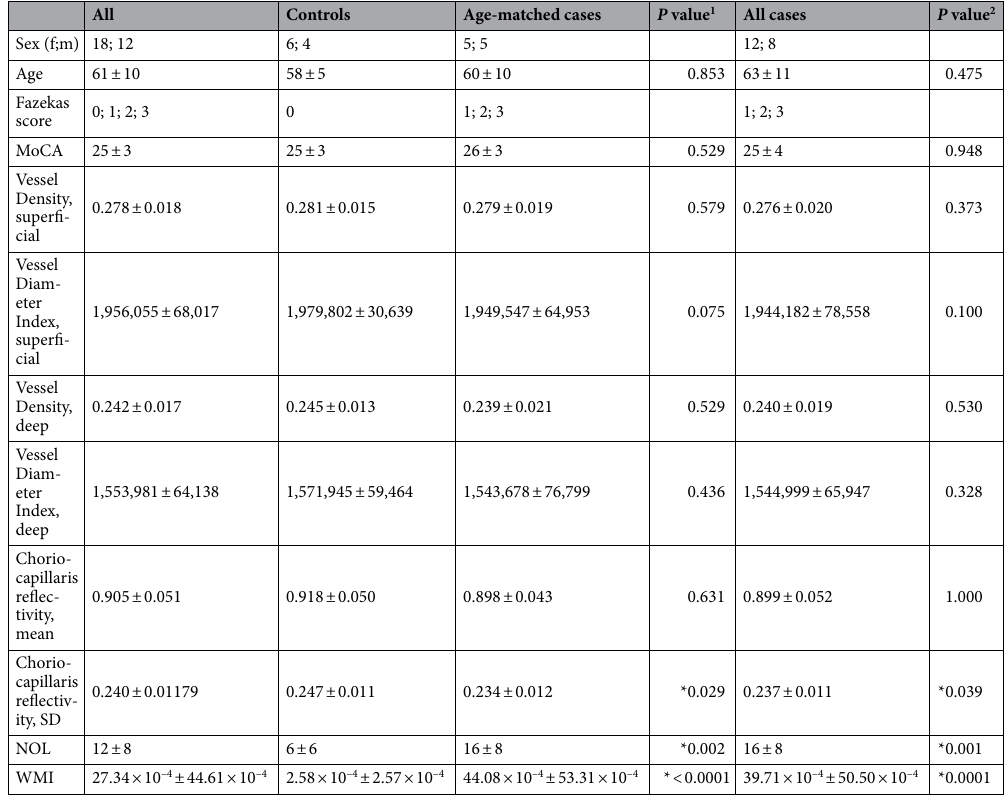
were healthy controls (Fazekas score 0) and 20 participants had CSVD (Fazekas score 1, n = 11; Fazekas score ≥ 2, n = 9). The average MoCA score was 25 ± 3 points, with no significant difference between cases and controls ( p = 0.948). In the total sample, choriocapillaris reflectivity standard deviation differed significantly between cases and controls ( p = 0.039; Fig. 2). The number and average size of flow voids did not differ between CSVD cases and controls ( p = 0.681 and 0.307, respectively) but the distribution of noticeably high or low numbers of flow voids was significantly different between both groups ( p = 0.040) and individuals with CSVD had on average either more or fewer choriocapillaris flow deficits than control participants. In addition, an analysis of the logarithmic association between the size of flow deficits and their number of occurrence using linear regression as suggested by Spaide revealed a significant difference in the intercepts ( p = 0.005) 20 . The unadjusted area under the ROC curve to detect participants with CSVD was significant for the choriocapillaris reflectivity standard deviation on OCT-A (0.735, 95%-confidence interval [0.544; 0.926], p = 0.039) (Supplementary Table 2 Supplementary Fig. 1). The logarithmically transformed WMI values as well as number of lesions were significantly associated with vessel density, vessel diameter index in both superficial and deep plexus as well as choriocapillaris parameters in unadjusted analyses (Supplementary Fig. 2). None of these associations remained significant when controlling for age (Table 2). Subsequently, two subgroup analyses were performed. Firstly, in an age-matched analysis of 10 cases and 10 controls, choriocapillaris reflectivity standard deviation differed significantly between the groups (Table 1). Similarly to the overall cohort, there were no significant differences regarding number and size of flow voids ( p = 0.481 and 0.190, respectively) but the above mentioned, significant difference in the distribution of flow voids remained present ( p = 0.049) and the difference in the linear regression intercepts remained significant ( p = 0.029). Secondly, in a subgroup of patients only ( n = 20), number of lesions was significantly associated with five OCT-A parameters of the superficial and deep retinal plexus (Table 3). After controlling for age, skeleton density of the deep retinal layer remained significant ( p = 0.041). WMI was not significantly associated with any of the OCT-A parameters in the CSVD subgroup.